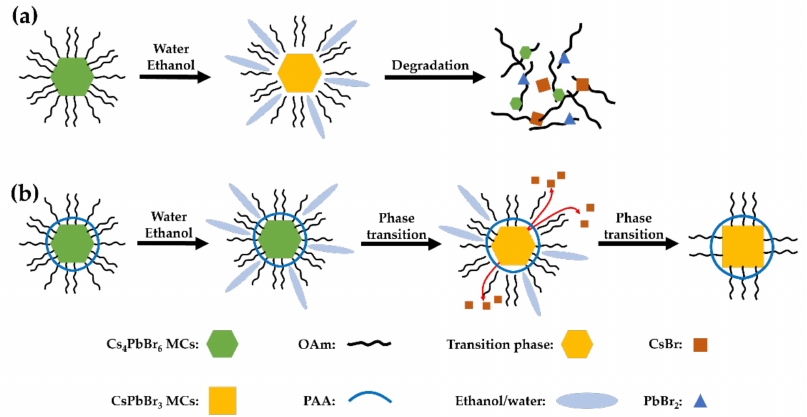
Figure 6. Schematic illustration of the phase transition process of Cs 4 PbBr 6 MCs obtained via ethanol/water treatment ( a ) without PAA and ( b ) with PAA.